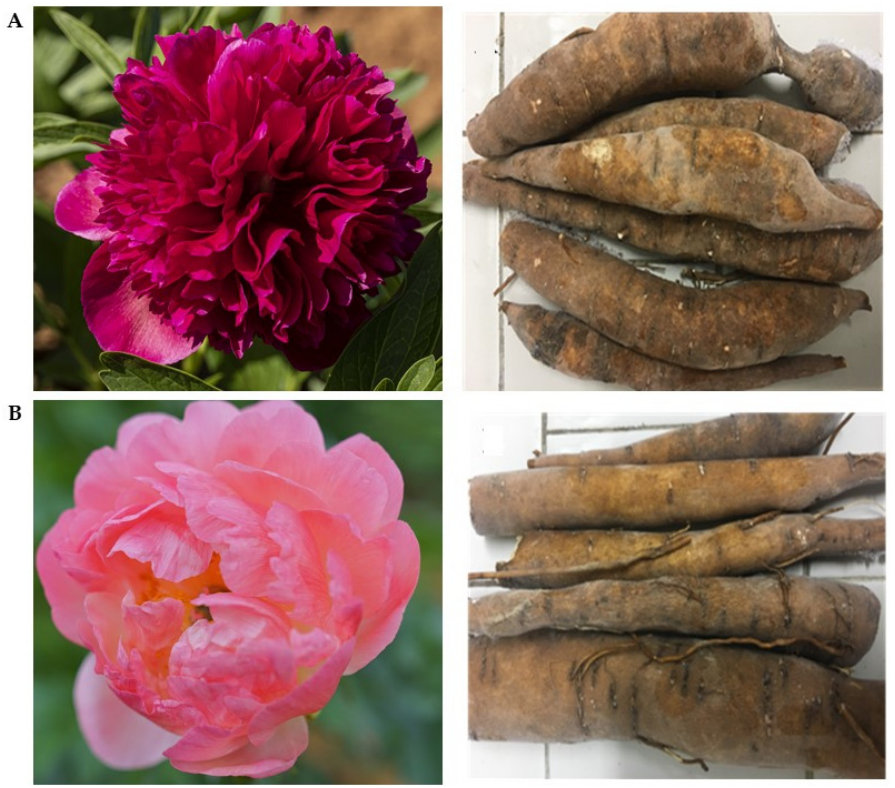
Figure 1. ( A ) Flower and roots of Paeonia officinalis “Rubra Plena” and ( B ) Flower and roots of Paeonia “Pink Hawaiian Coral”.